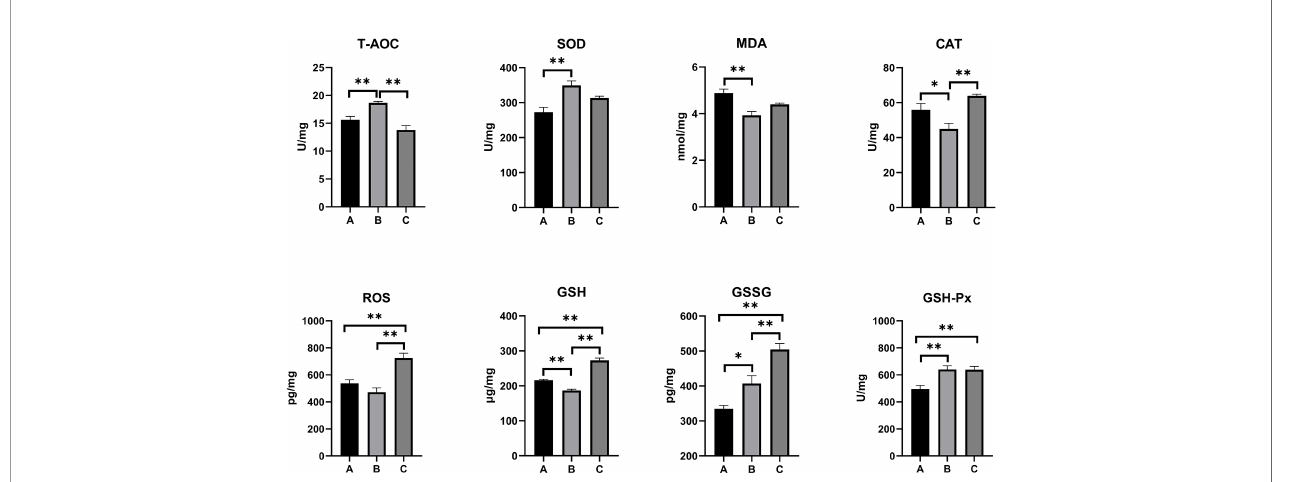
FIGURE 4 | Effects of OTA and AFB1 on liver oxidative stress and antioxidant status of pullets after 42 days (n = 6, mean ± SEM), including T-AOC, SOD, MDA, CAT, ROS, GSH, GSSG, and GSH-Px. Groups A, B, and C are the control group, the pair-feeding group, and the OTA+AFB1 group, respectively. Data were analyzed with ANOVA and Tukey ’ s HSD, and signi fi cant differences were de fi ned as * p < 0.05 and ** p < 0.01. OTA, ochratoxin A; AFB1, a fl atoxin B1; T-AOC, total antioxidant capacity; SOD, superoxide dismutase; MDA, malondialdehyde; CAT, catalase; ROS, reactive oxygen species; GSH, glutathione; GSSG, oxidized glutathione; GSH-Px, glutathione peroxidase; HSD, honestly signi fi cant